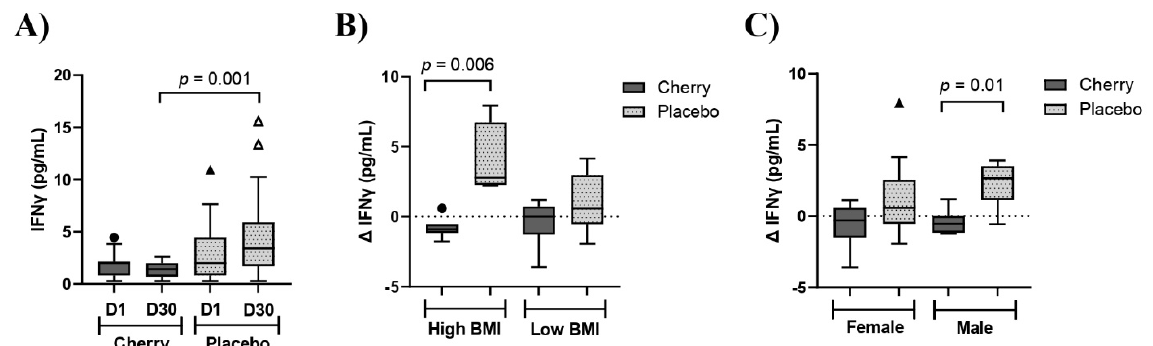
Figure 4. DSC supplementation decreased IFN γ in male obese adults with high BMI. ( A ) IFN γ (pg/mL) levels in cherry and placebo groups. Difference between treatments was determined by 2- way ANOVA analysis followed by Š í d á k multiple comparison test. ( B ) ∆ IFN γ (pg/mL) stratified by low (30–34) and high (35–40) BMI ( C ) IFN γ (pg/mL) stratified by sex. Difference between treatments was assessed by Mann-Whitney test. Box plots show lower quartile, median, upper quartile, and Tukey whiskers. Data not included in the whiskers are plotted as outliers. ∆ : D30-D1. IL-1 β is a cytokine that promotes inflammation and is elevated in obese individuals [18]. IL-1 β was significantly different between cherry and placebo groups at D1 ( p = 0.05), thus, the mean change ( ∆ ) from D30 to D1 was computed to evaluate differences between treatments. Results showed that ∆ IL-1 β tended to be lower in the cherry group ( ∆ = − 0.02, 95%CI: − 0.30, 0.25) compared to placebo ( ∆ = 0.13, 95% CI: − 0.18, 0.45) but the difference between treatments did not reach